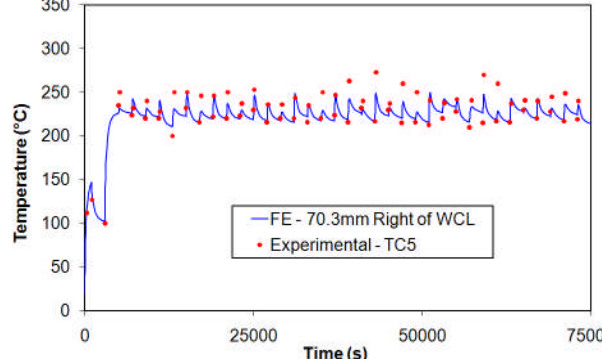
Figure 14. Temperature measurements by TC5 and FE temperature history.